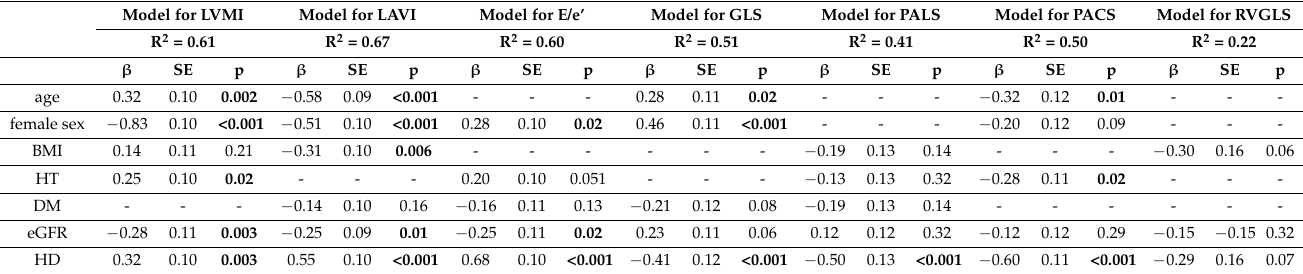
Table 4. Associations of cardiac function and morphological parameters with demographic and clinical characteristics: multivariate